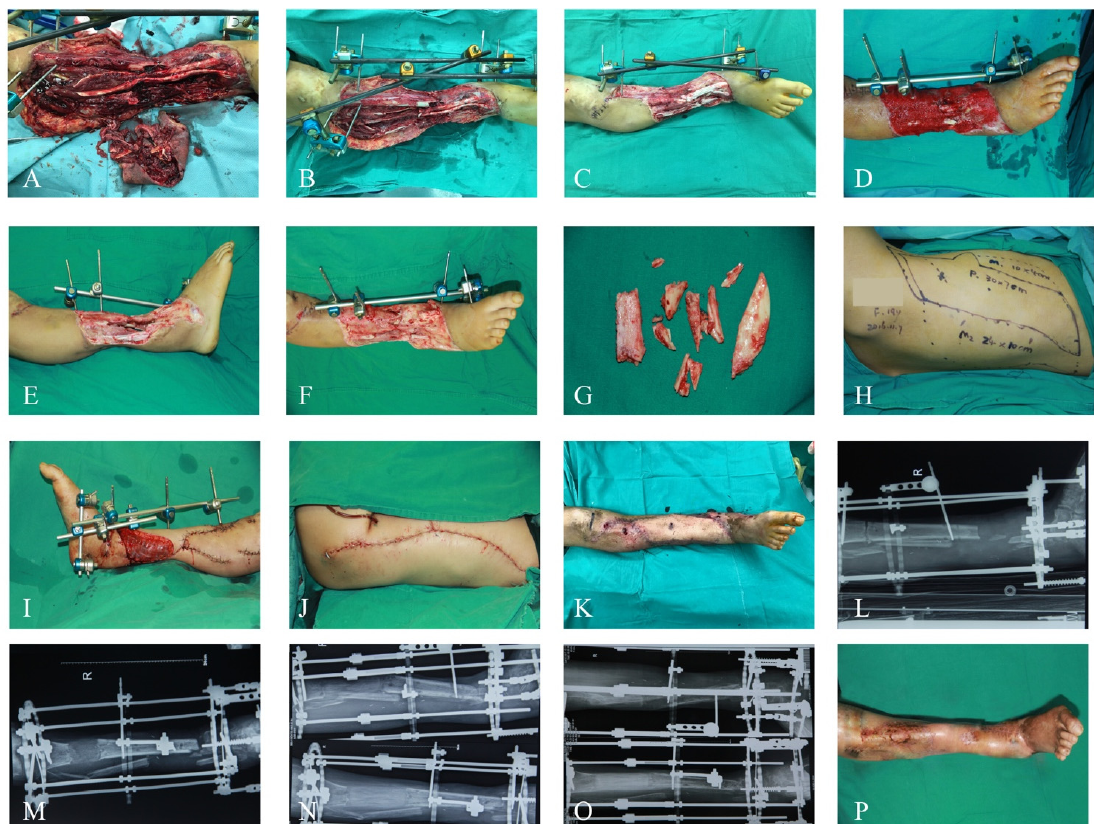
Figure 3. Delayed-Repair Case Report. A 19-year-old male patient with several lower-extremity